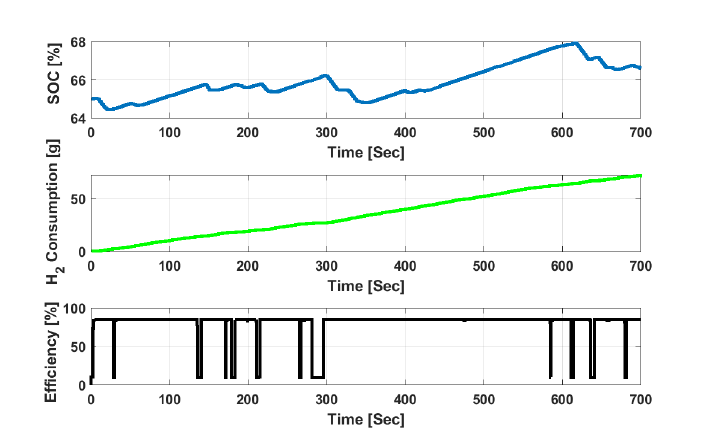
Figure 17. SOC , H 2 consumption, and overall efficiency for the EMS based on FDFLC.